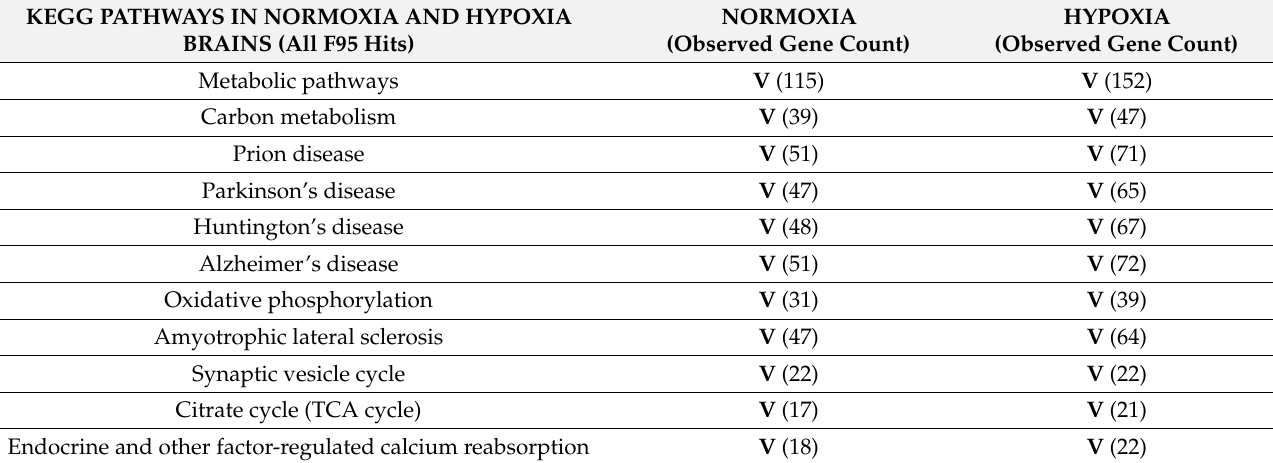
Table 6. KEGG pathways for all F95-enriched proteins in naked mole-rat brains following normoxia or hypoxia treatment. A tick ( V ) indicates whether the pathway was identified; the observed gene count for each pathway is indicated in brackets. Pathways identified in normoxia brains only are highlighted in blue, and those identified in hypoxia brains only in pink. A full list of the protein hits underlying the network analysis is provided for both groups in Supplementary Tables S1 and